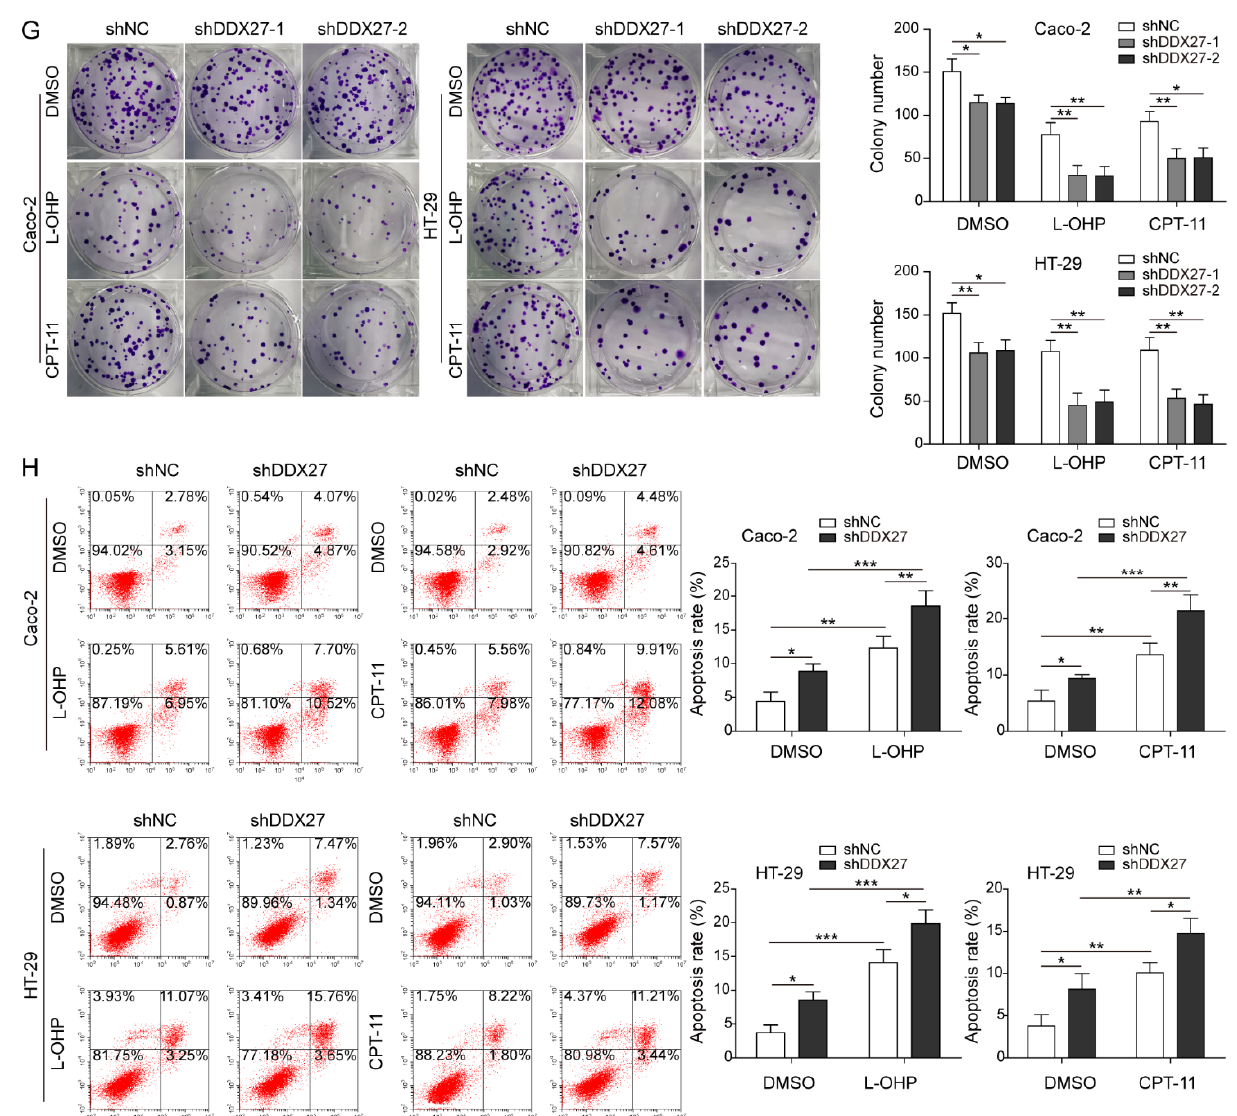
Figure 4. Knockdown of DDX27 inhibits stemness and increases chemosensitivity in CRC cells. ( A ) The protein level of DDX27 was detected by Western blot analysis. ( B ) The sphere-forming abilities of CRC cells were monitored by sphere formation assay. ( C ) The cell population of CD44 + CD133 + cells was detected by flow cytometry. ( D ) The CD44 or CD133 level in CRC cells was detected by IF staining. Red, CD44; green, CD133; blue, DAPI. Scale bar, 25 μ m. ( E ) The protein levels of stemness markers (CD44, CD133, SOX2, OCT4, NANOG) were detected by Western blot analysis. ( F ) Cell viability was monitored by CCK-8 assay. ( G ) The colony-forming abilities of CRC cells were assessed by colony formation assay. ( H ) Cell apoptosis was measured by Annexin V-FITC/PI staining. Each experiment was performed at least three times independently. *, p < 0.05, **, p < 0.01, ***, p < 0.001. Full pictures of the Western blots are presented in Figure S2.